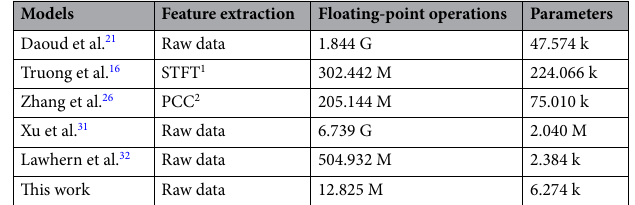
Table 4. The feature extraction methods, floating-point operations, and parameters of different model. 1 Short- time Fourier transform. 2 Pearson correlation